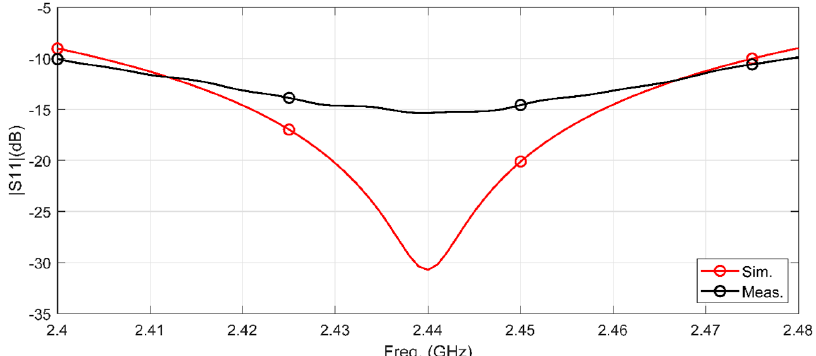
Figure 2. Electromagnetically coupled microstrip patch antenna’s simulated and measured reflection coefficient in free-space.